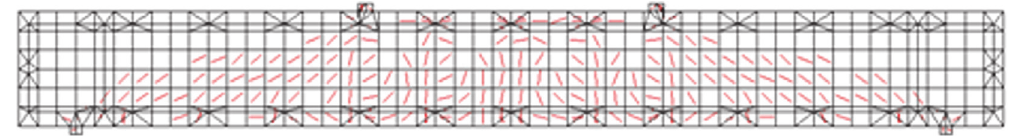
Figure 15: Typical map cracks in shear region of beams B7-B8 (VecTor2 analysis).